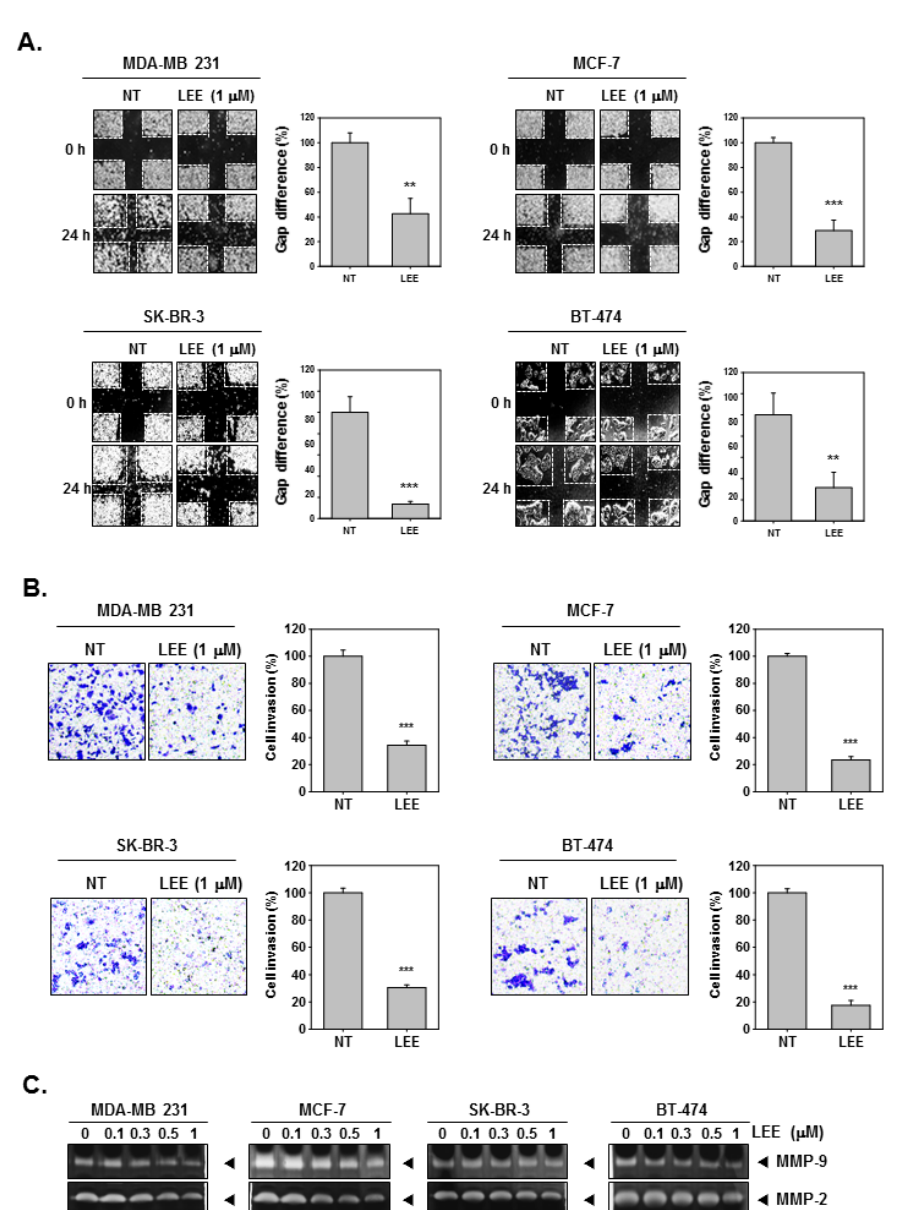
Figure 2. Inhibitory effects of LEE on cell invasion and migration. ( A ) Cell migration was evaluated by wound healing assay. ( B ) Cell invasion was observed by Boyden chamber assay. ( C ) MMP-9/2 activity was evaluated by zymography assay. Supernatants were obtained, concentrated, and analyzed. All the experiments were individually repeated at least thrice. *** p < 0.001 vs. non-treated (NT) cells, and ** p < 0.01 vs. non-treated (NT) cells.